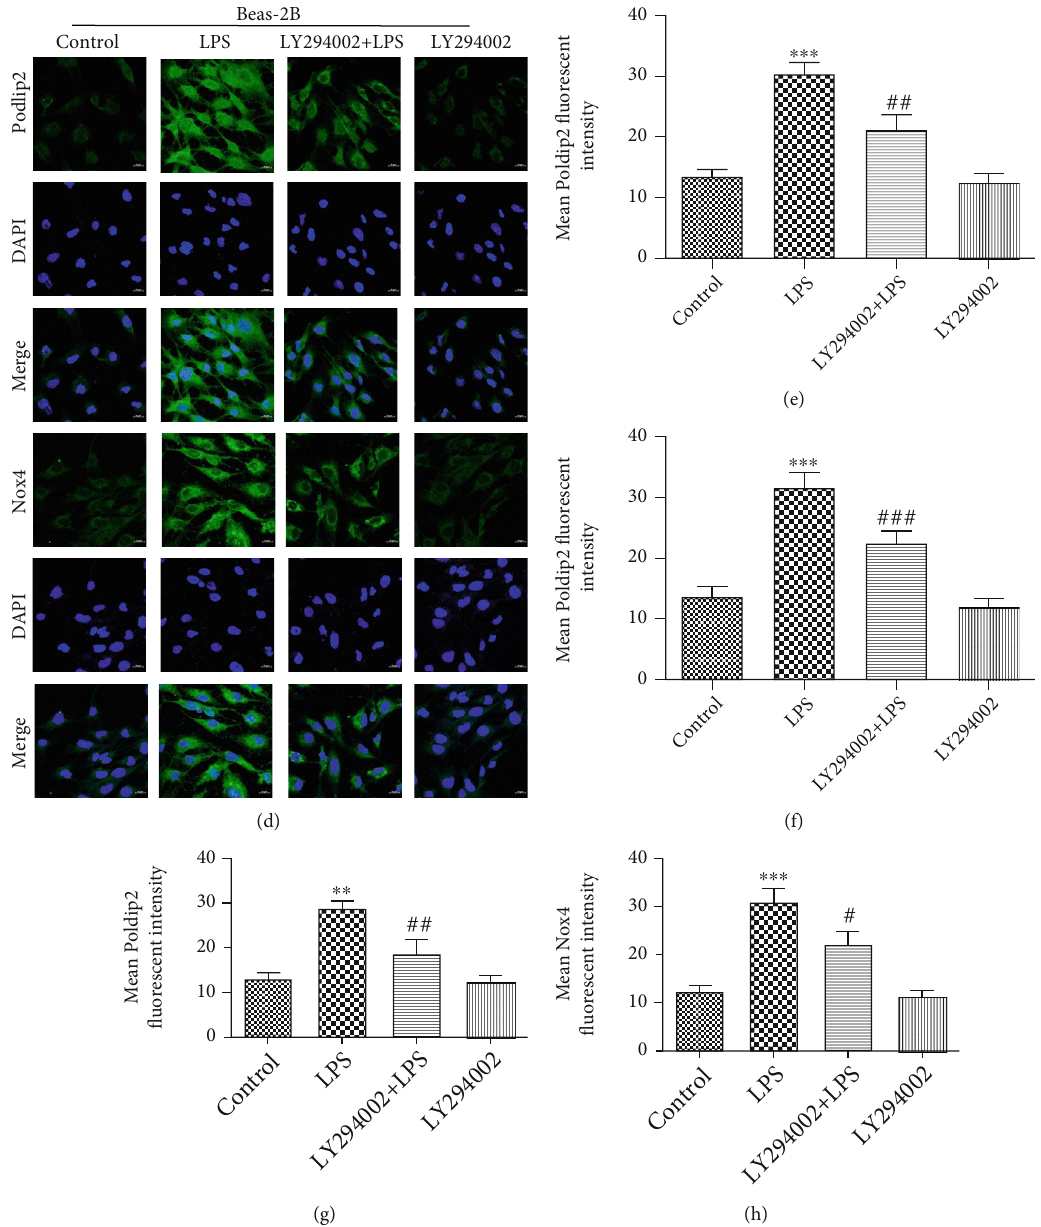
Figure 7: E ff ects of PI3K-AKT signaling on the activation of the Poldip2/Nox4-mediated pathway. Con fl uent A549 and Beas-2B cells were pretreated with 10 μ mol/L LY294002 for 1h followed by postincubation with LPS (10 μ g/mL for A549 cells and 1 μ g/mL for Beas-2B cells) for 12 h. (a, b) The protein levels of p-AKT, AKT, Poldip2, Nox4, HO-1, and COX-2 were detected by Western blotting and quantitatively analyzed. (c – h) The expression of Poldip2 and Nox4 in cells was detected by immuno fl uorescence analysis and a laser confocal microscope. The cells were stained with Poldip2 (green), Nox4 (green), and counter-stained with DAPI (blue) (magni fi cation of 400x). Bars are mean ± SD of 3 independent experiments. ∗∗∗ P < 0 : 001 vs. control, ∗∗ P < 0 : 01 vs. control, ∗ P < 0 : 05 vs. control, ### P < 0 : 001 vs. LPS, ## P < 0 : 01 vs. LPS, and # P < 0 : 05 vs.